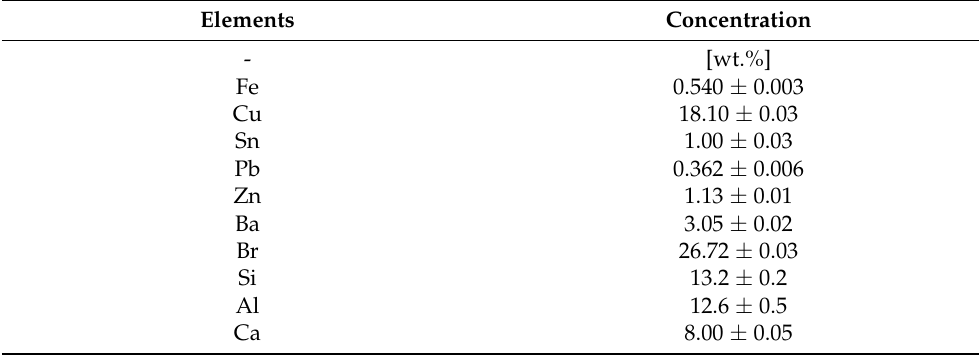
Table 1. Chemical composition of input materials.